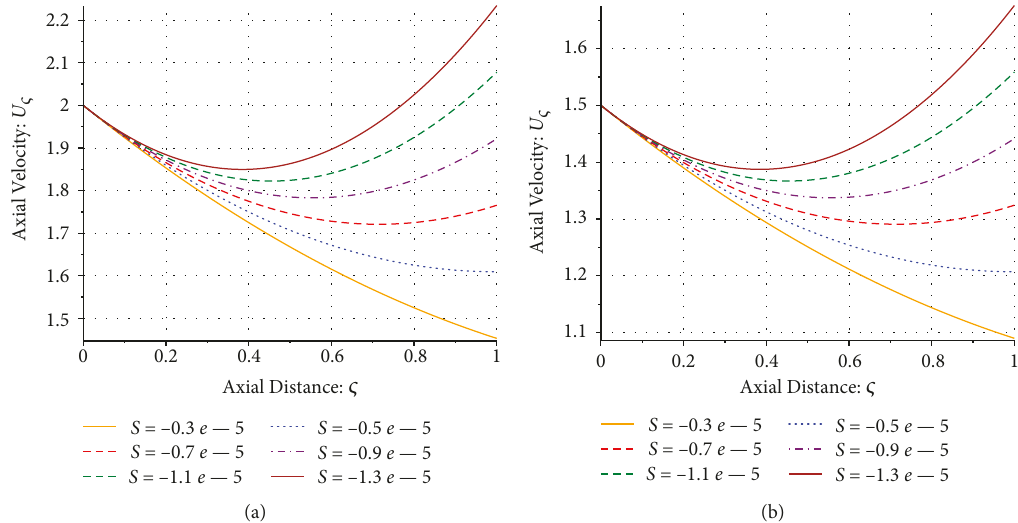
Figure 2: Behavior of axial velocity U